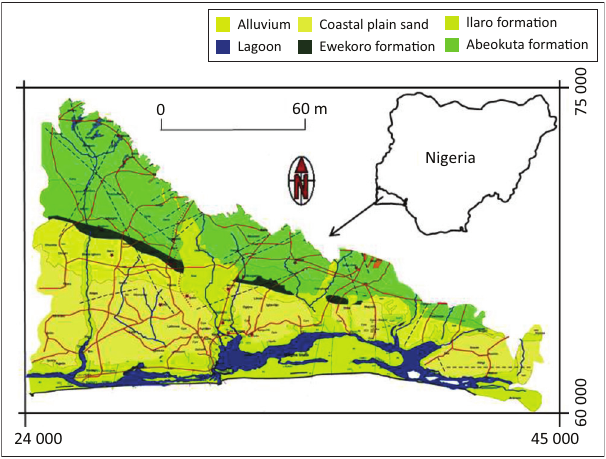
FIGURE 1: Location of sedimentary basin of southwestern Nigeria with respect to